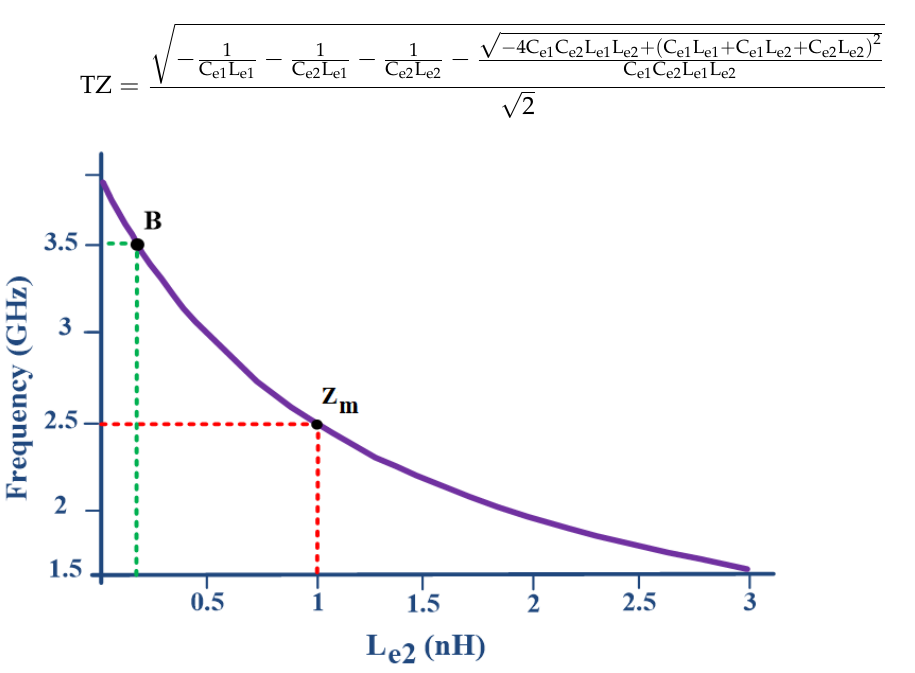
Figure 6. The relationship between the location of TZ and the value of the L e2 inductor.